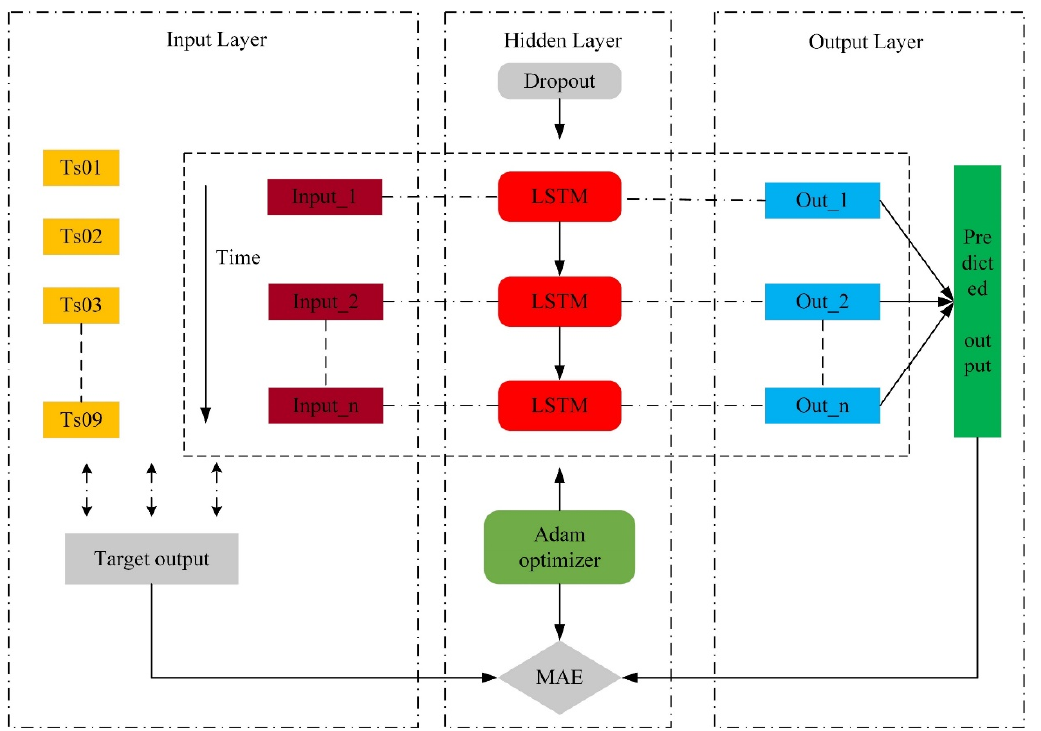
Figure 6. LSTM topological structure diagram.